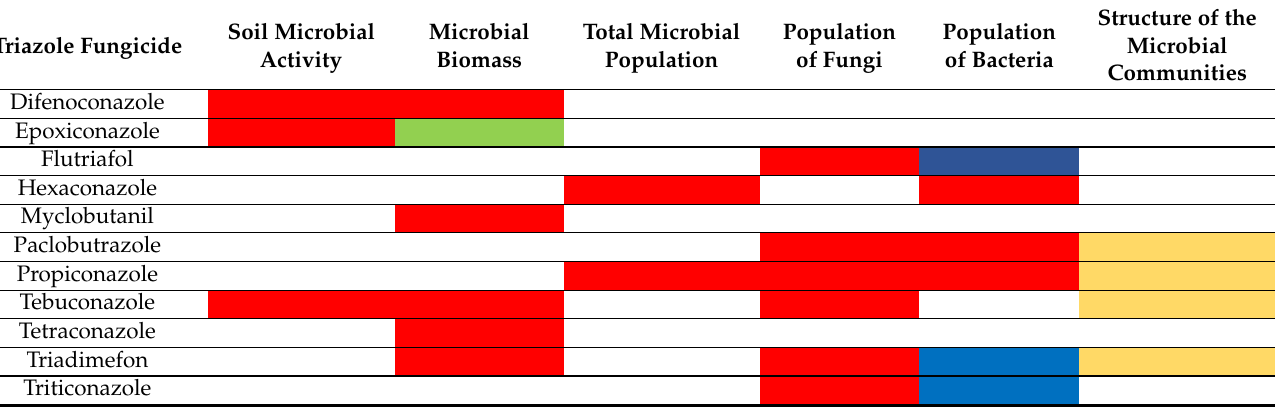
Table 2. Effects of high doses of triazole fungicides on soil microorganisms: red cells indicate decreased values compared to the control, blue cells indicate increased values compared to the control, green cells reveal no effects of the fungicides on the soil microbiota, yellow cells illustrate modifications in the structure of microbial communities, white cells correspond to the lack of available